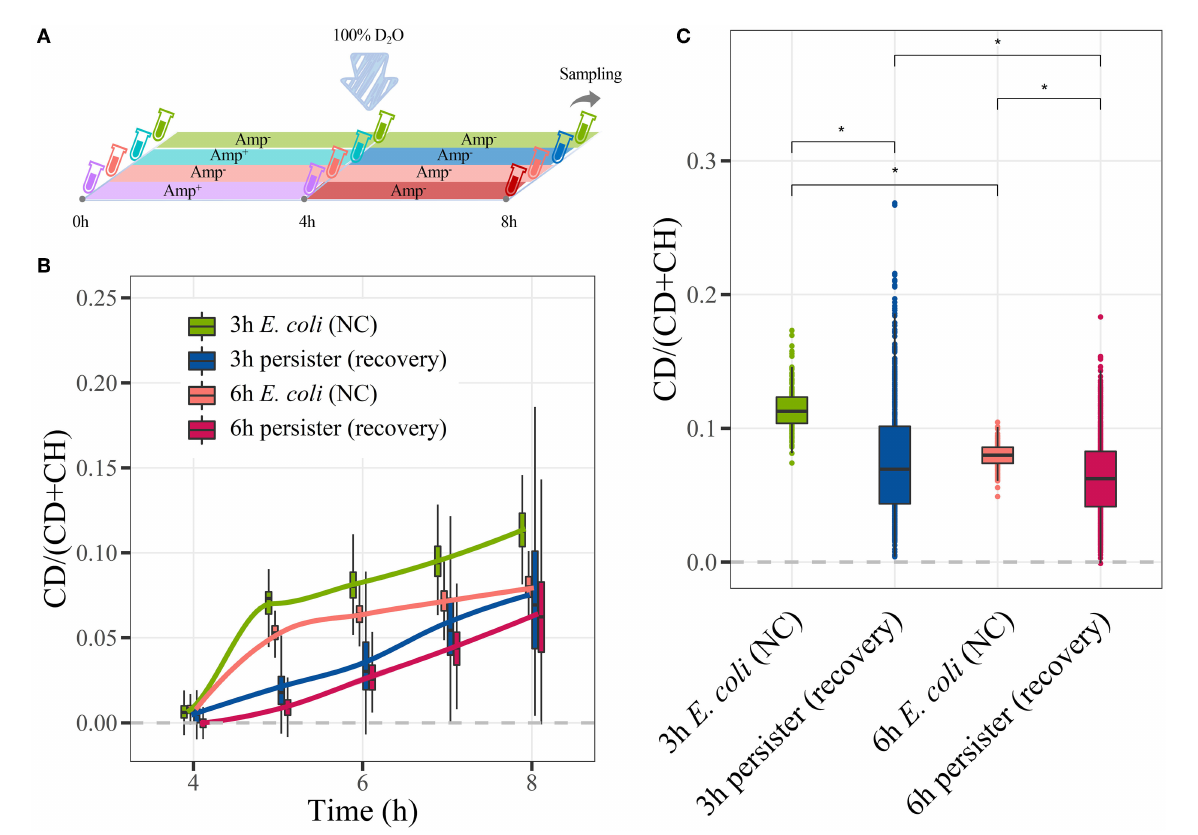
FIGURE7 C-D ratio of E. coli persisters during resuscitation. Overnight planktonic-cultured E. coli (12h) was 1:100 diluted into fresh LB broth and further cultured for 3h and 6h, followed by ampicillin treatment (100 µ g/mL, 32 × MIC) for 4h. Then, the persisters were washed two times with Milli-Q water and further cultured in LB broth with 100% D 2 O without the drug for another 4h. Single-cell Raman spectra were obtained at every hour. (A) Workflow of D 2 O labeling strategy. (B) Time-dependent C-D ratio of persisters and E. coli cells during resuscitation. (C) C-D ratio of persisters and E. coli cells after 4h of resuscitation. N > 50 for each group. NC: E. coli cells without ampicillin treatment; * P < 0.0001